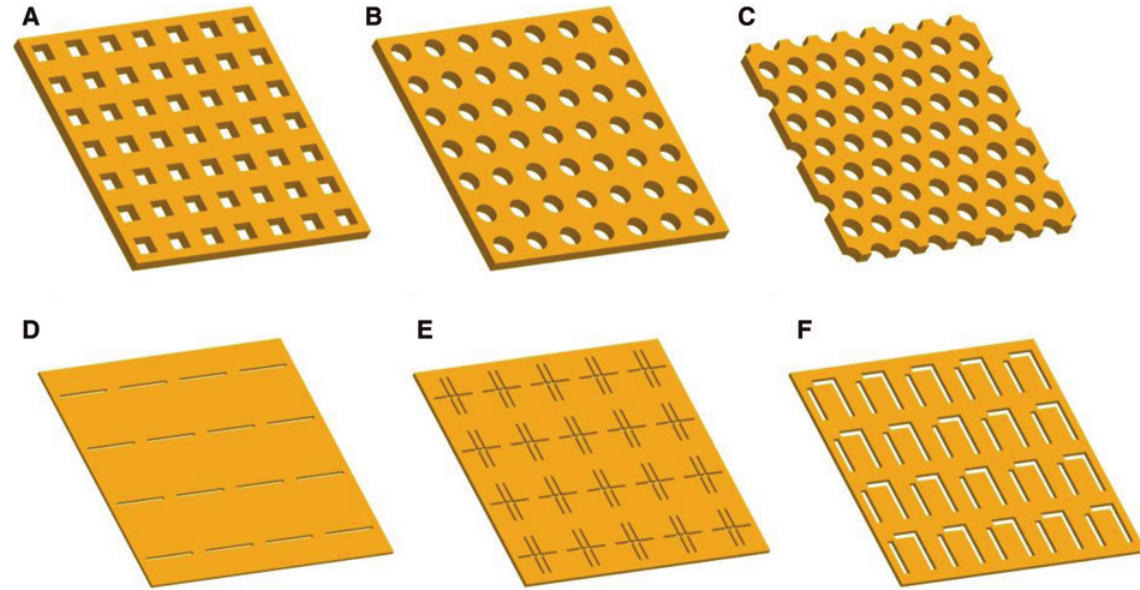
Figure 15: Various hole-based